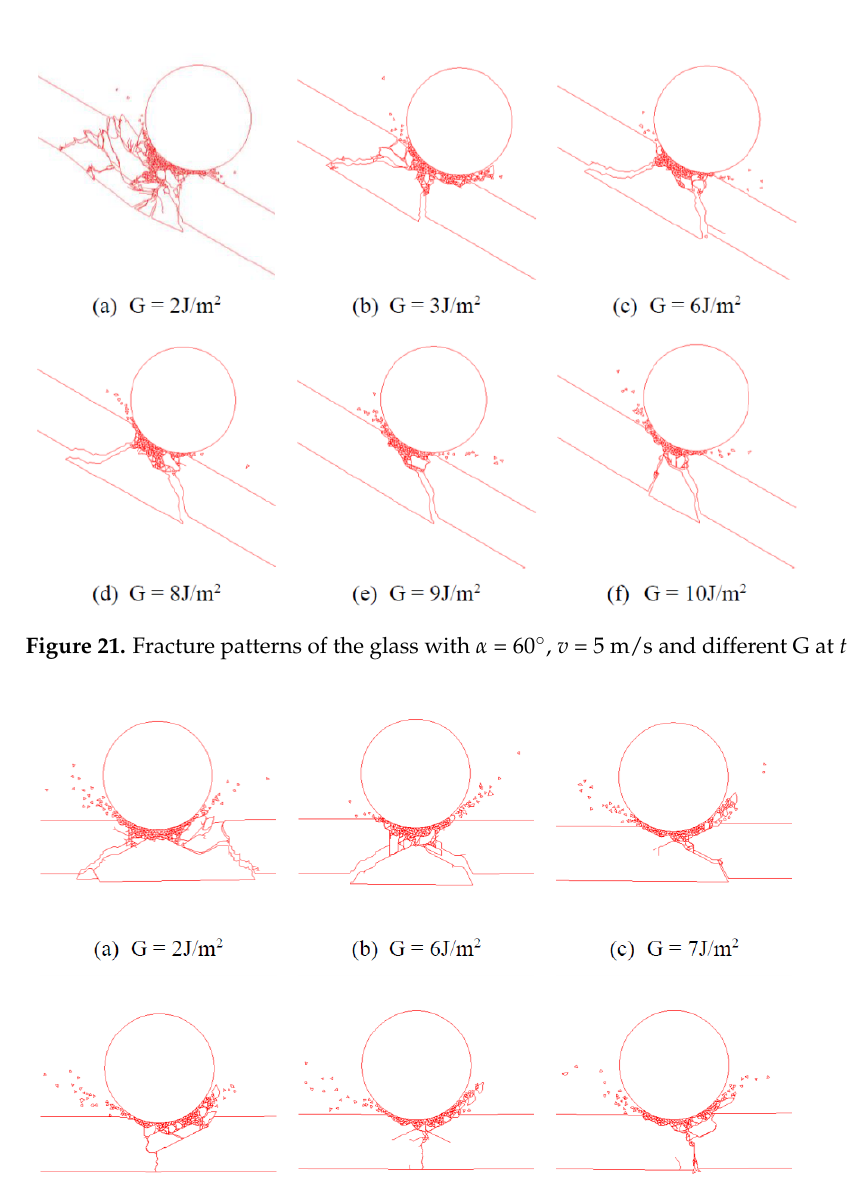
Figure 20. Fracture patterns of the glass with α = 90°, v = 5 m/s and different f t at t = 1 ms. Table 7. Impact failure modes at v = 5 m/s with different tensile strengths of glass.